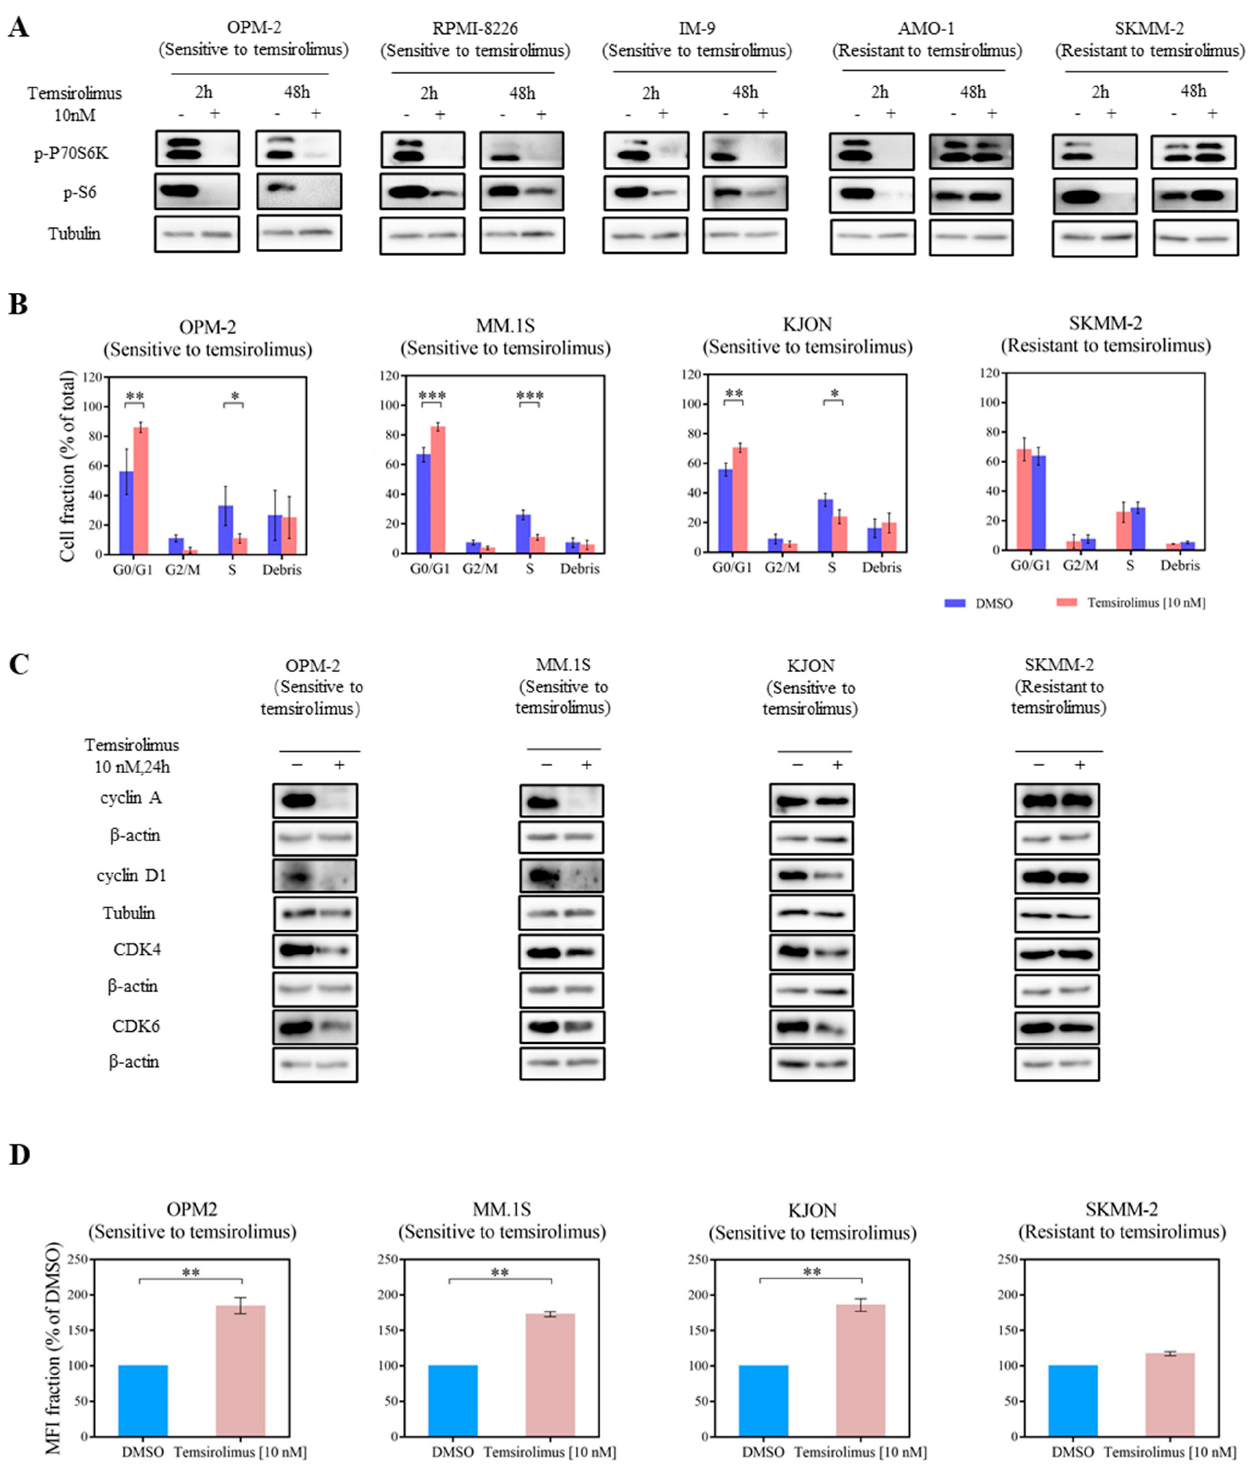
Figure 2. Temsirolimus is active in vitro. ( A ) Treatment with 10 nM of temsirolimus for 2 h resulted in decreased phosphorylation of P70S6K and S6 in OPM-2, RPMI-8226, IM-9, AMO-1, and SKMM-2 cell lines. A restoration of P70S6K and S6 phosphorylation was observed in AMO-1 and SKMM-2 cell lines after treatment with 10 nM temsirolimus for 48 h. Tubulin was the loading control. These results are representative of three separate experiments. ( B ) Temsirolimus treatment induced cell cycle arrest. 24 h of inhibitor treatment resulted in an increase of G 0 /G 1 stage in OPM-2, MM.1S, and KJON cell lines, whereas no cell cycle arrest was detectable in the SKMM-2 cell line. Data are ex- pressed as the means ± standard deviation of at least 3 independent experiments. Error bars indicate standard deviations. * p ≤ 0.05, ** p ≤ 0.01, *** p ≤ 0.001. ( C ) Treatment with 10 nM temsirolimus for 24 h resulted in decreased cyclin D1, CDK4, and CDK6 in OPM-2, KJON, and MM.1S cell lines and decreased cyclin A in OPM-2 and MM.1S cell lines. No downregulation could be observed in the SKMM-2 cell line. Tubulin and β -actin were the loading controls. These results are representative of